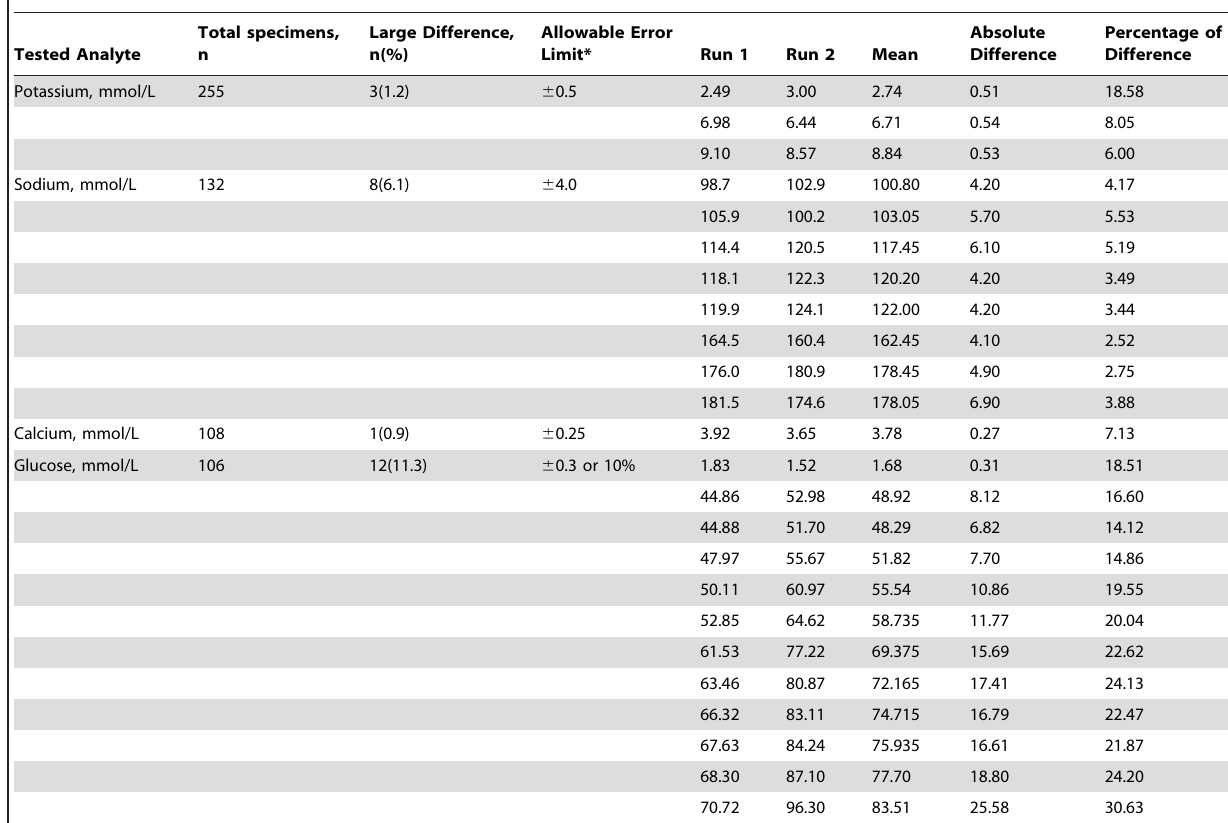
Table 4. Features of the Large Difference.